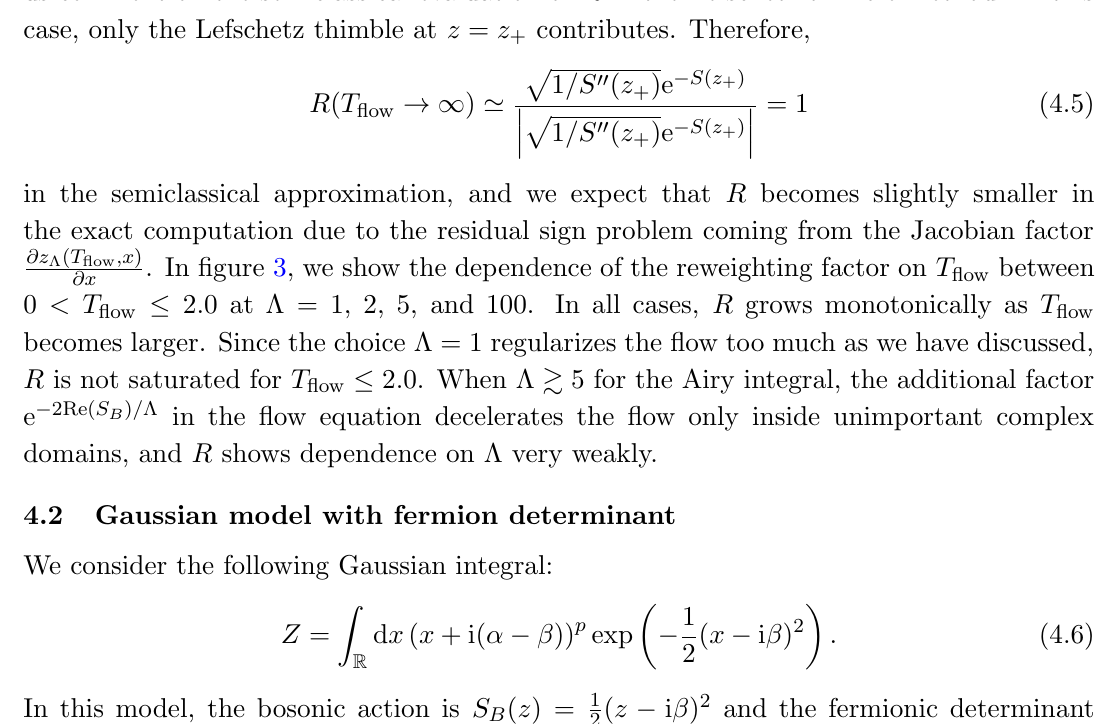
Figure 2 . Complex contours J (cid:3) ( T (cid:13)ow ) for the Airy integral. The black dashed curves in the left (cid:12)gure show (cid:13)ow lines with initial condition at the intersection with the real axis. The saddle point is denoted by the blue dot which is intersected by the Lefschetz thimble in the left (cid:12)gure. When T = 0, then J (0) = R and this reweighting factor vanishes for the Airy integral, (cid:3) (cid:13)ow R ( T ) = 0. In order to get a better understanding of the qualitative behavior of R , (cid:13)ow